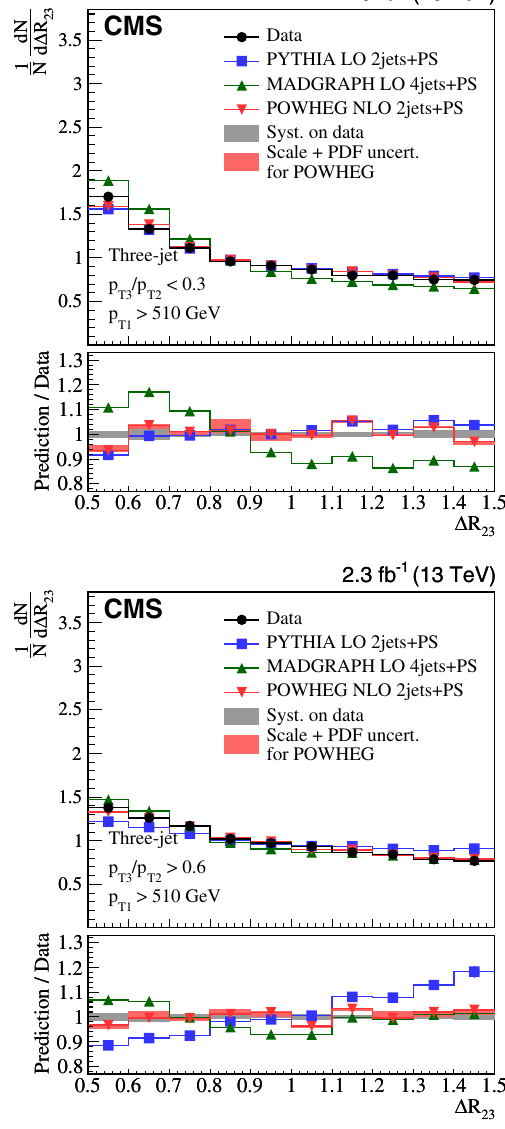
√ Fig. 5 Three-jet events at s = 13TeV and comparison to theoretical predictions: (upper) Δ R 23 for soft radiation ( p T3 / p T2 < 0 . 3), (lower) Δ R / p > 0 . 23 for hard radiation ( p T3 T2